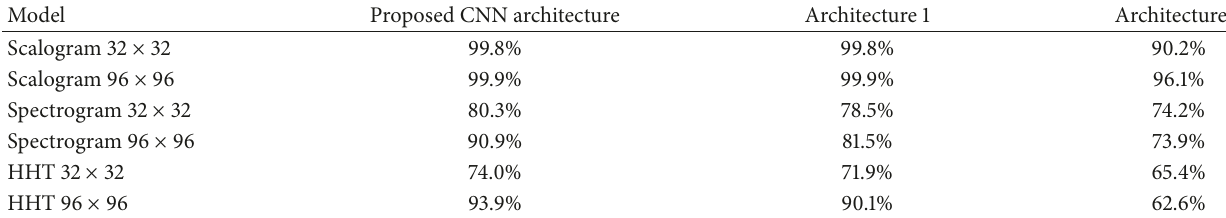
Table 13: 𝐹 -measure for MFPT data set.